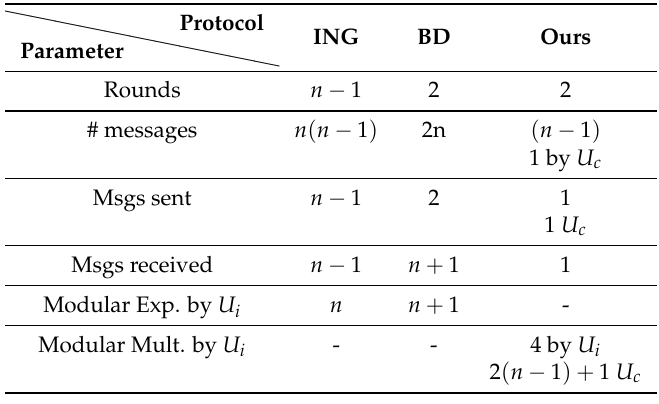
Table 1. Comparison of